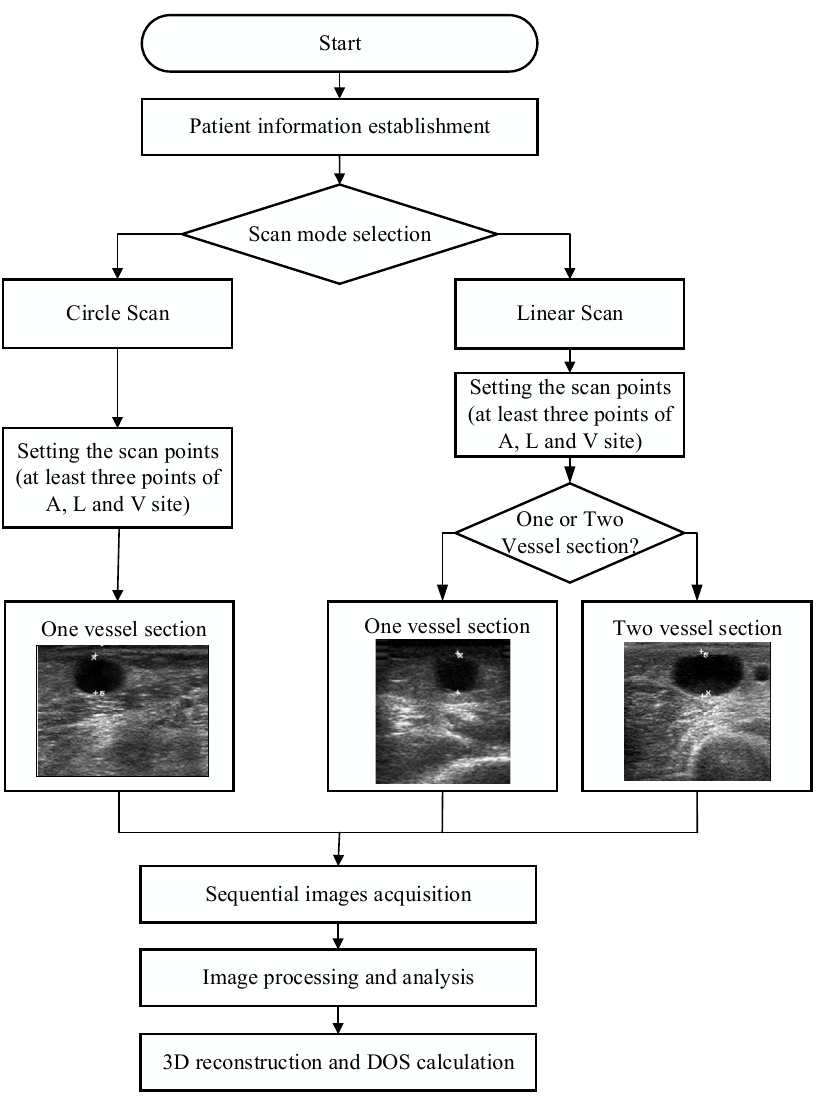
Figure 5. The flowchart of RUS operation and image processing.